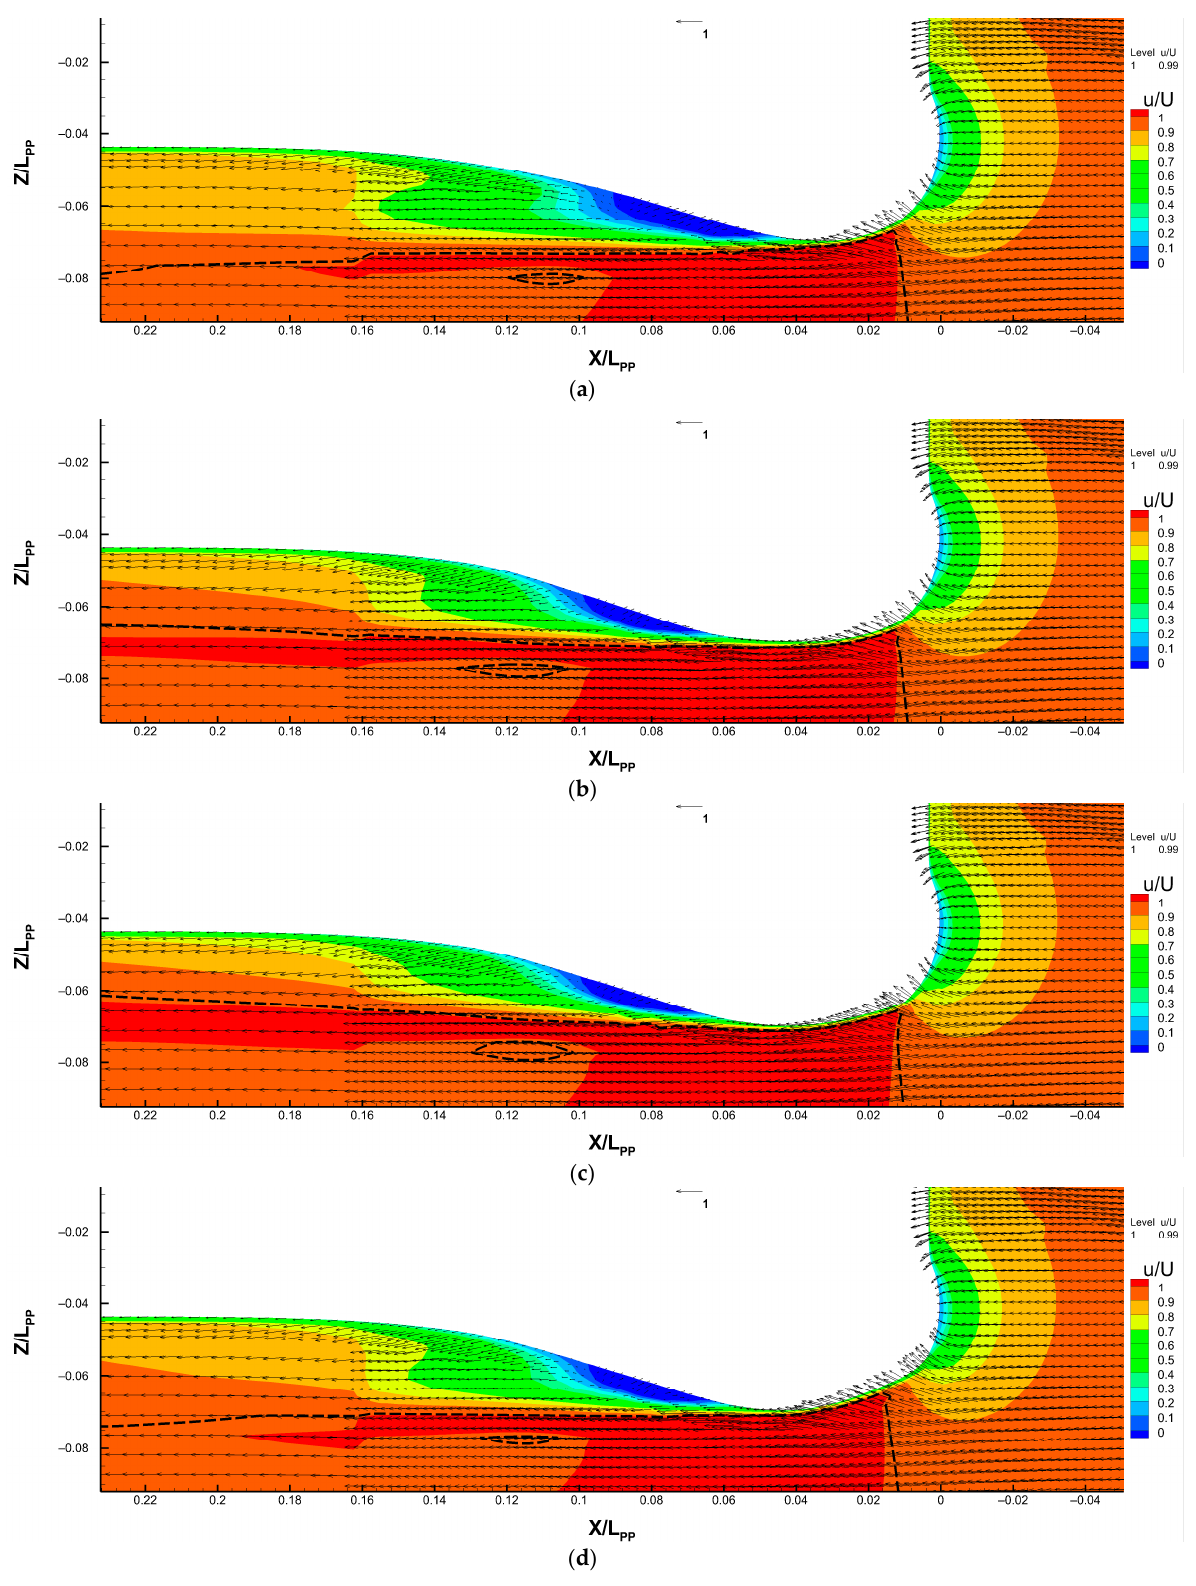
Figure 11. Velocity flow field around the sonar dome (on Y = 0 plane). ( a ) Original sonar dome, ( b ) A17.830, ( c ) B17.018 and ( d ) B17.018v. The arrows illustrate the velocity vector field ( u/U , v/U ) with the reference vector length for the velocity magnitude equal to 1 showed on the middle top of each figure. The dashed lines represent the u/U = 0.99 contour line, i.e., boundary layer location.